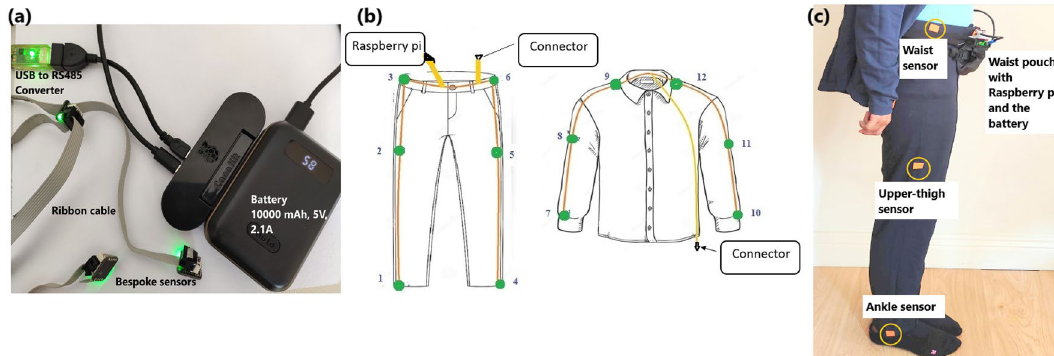
Figure 1. ( a ) Components of the sensor system. ( b ) Sensor placement on clothes. ( c ) Sensor placement on trousers. 12 IMUs are connected to a synchronous bus via ribbon cable. The sensors are connected to a Raspberry Pi via a USB to RS485 converter, and the Pi was powered by a battery pack. Lights on the sensors provided assurance of the sensors’ operation but were not visible outside the clothing. The Pi and battery